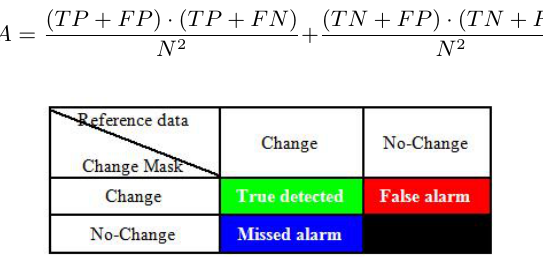
Figure 9: Color coding scheme of changes shown in change masks